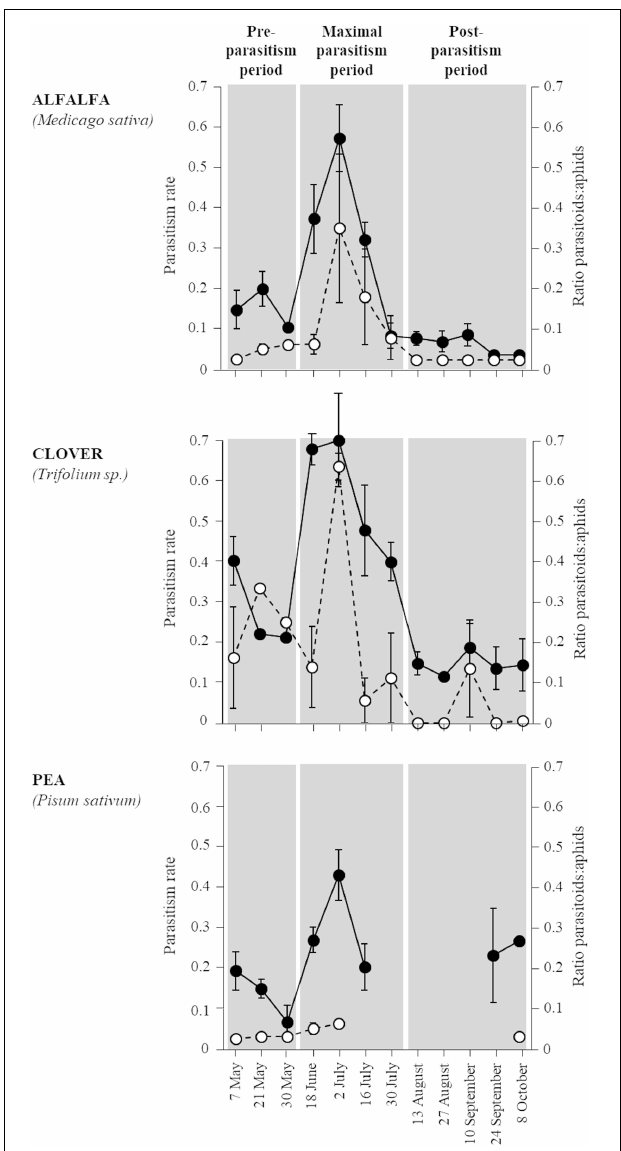
FIGURE 1 | Temporal variation in parasitism pressure in alfalfa, clover, and pea crops estimated using two proxies: parasitism rate (black dots, —) and the ratio of the number of parasitoids/pea aphid individuals (white dots, –). The three shaded areas within each graph correspond to the three parasitism periods arbitrarily defined: “pre-parasitism,” “maximum parasitism,” and “post-parasitism” periods. Error bars represent standard